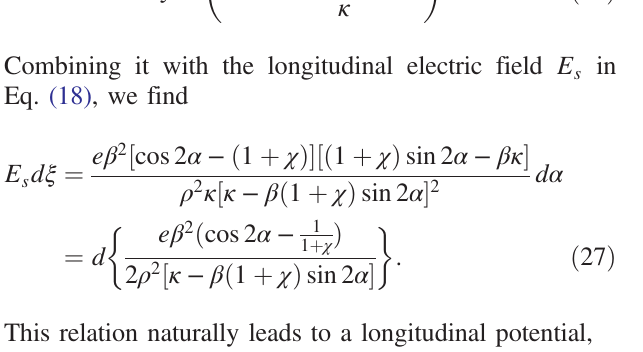
ρ 2 =e 2 as a function of μ ¼ 3 γ 3 ξ and ν ¼ γ 2 χ x